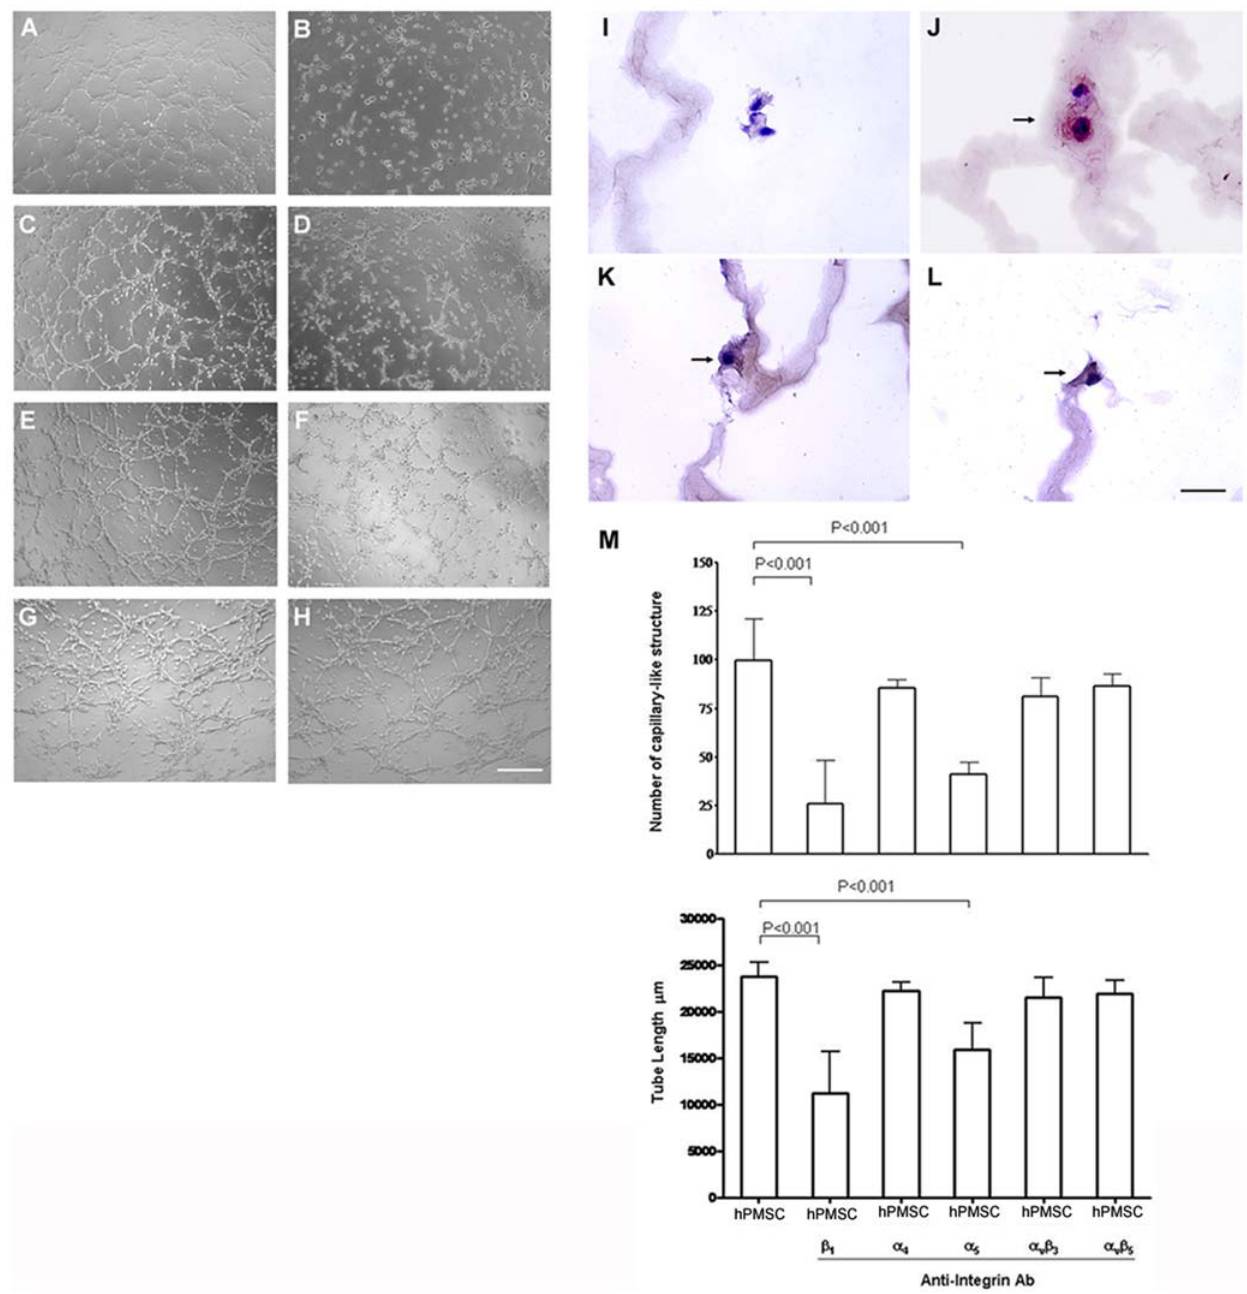
Figure 5. In vitro angiogenesis: formation of capillary-like structures by differentiated human placental multipotent mesenchymal stromal cells (hPMSCs). hPMSCs were trypsinized, seeded on wells coated with ECMatrix TM . (A) Human umbilical vein endothelial cells and (B) undifferentiated hPMSCs were used as positive and negative control (shown after 6 hours of culture). (C) hPMSCs induced to differentiate into endothelial cells form characteristic capillary-like structures. Cell elongation and cell interconnecting cell networks were observed. Differentiated hPMSCs were pretreated with antibodies against (D) integrin b 1 , (E) a 4 , (F) a 5 , (G) a v b 3 , or (H) a v b 5 . Scale bar: 200 m m. Representative photomicrographs of 3 different experiments are shown. This ability of differentiated hPMSCs to form capillary-like structures was strongly diminished when integrin b 1 or a 5 was inhibited. Blocking antibodies to integrins a 4 , a v b 3 , or a v b 5 did not inhibit the formation of capillary-like structures. The capillary-like structures on ECmatrix TM gel were immunostained using antibody against (I) non-specific IgG or specific endothelial markers (J) von Willebrand factor, (K) CD31, and (L) CD105. Scale bar: 50 m m. Arrows indicate von Willebrand factor, CD31 and CD105 positive cells present in ECmatrix TM gel. (M) Quantification of the capillary-like structures by measuring the polygonal network (upper panel) and the cumulative tube length (lower panel) formed by differentiated hPMSCs. A significant inhibition of capillary-like structure formation was observed when integrin b 1 or a 5 antibody was applied to the cells. Error bar: SD.